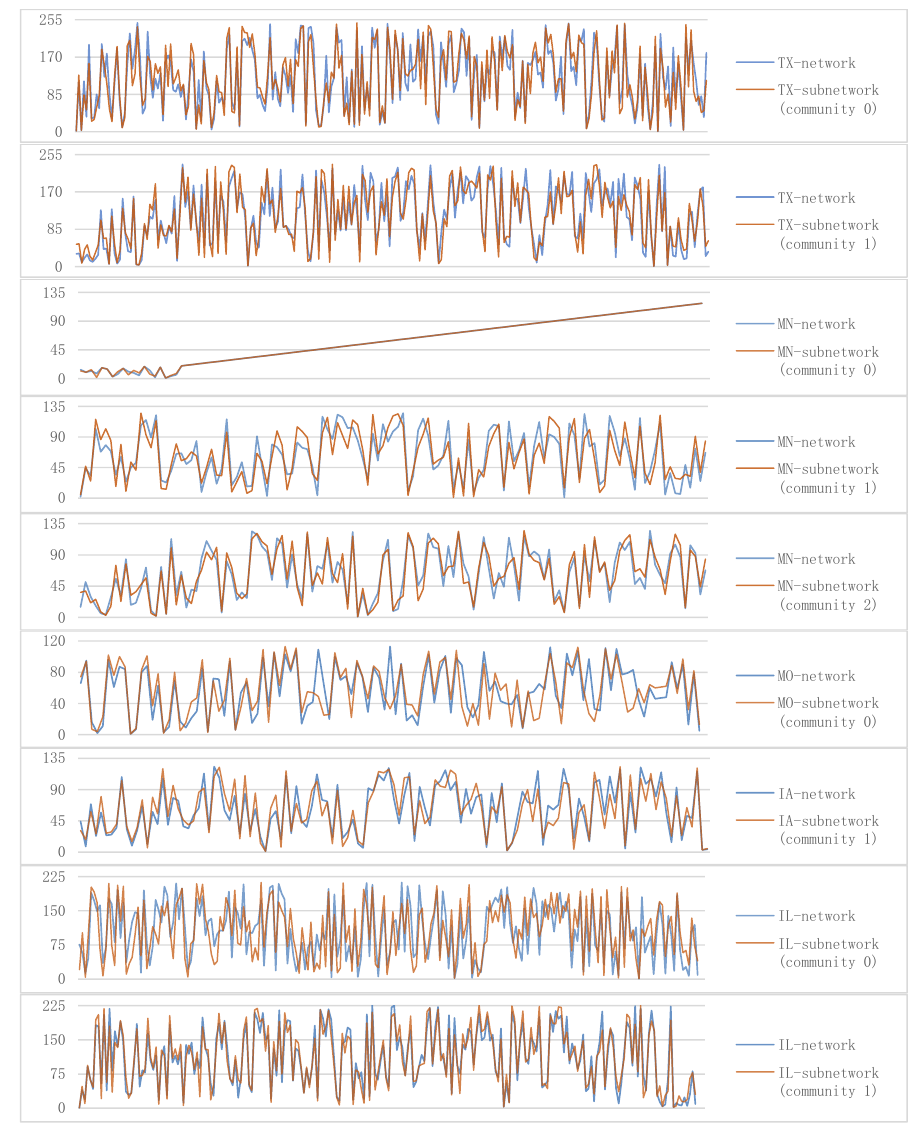
Figure 6. Comparison of the PR values in the original network and community sub-network of five